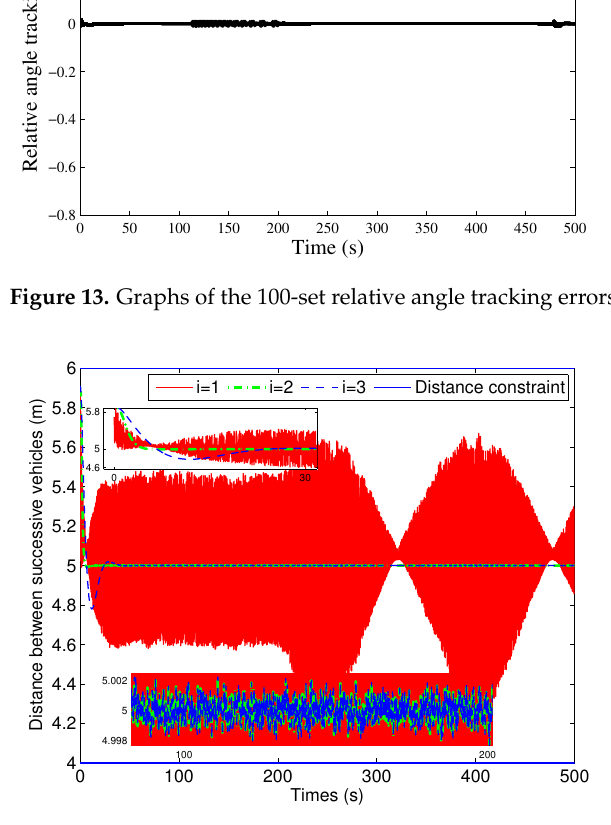
Figure 14. The LOS range d i , the maximum connectivity distance and minimum collision distance under 1 m noise.